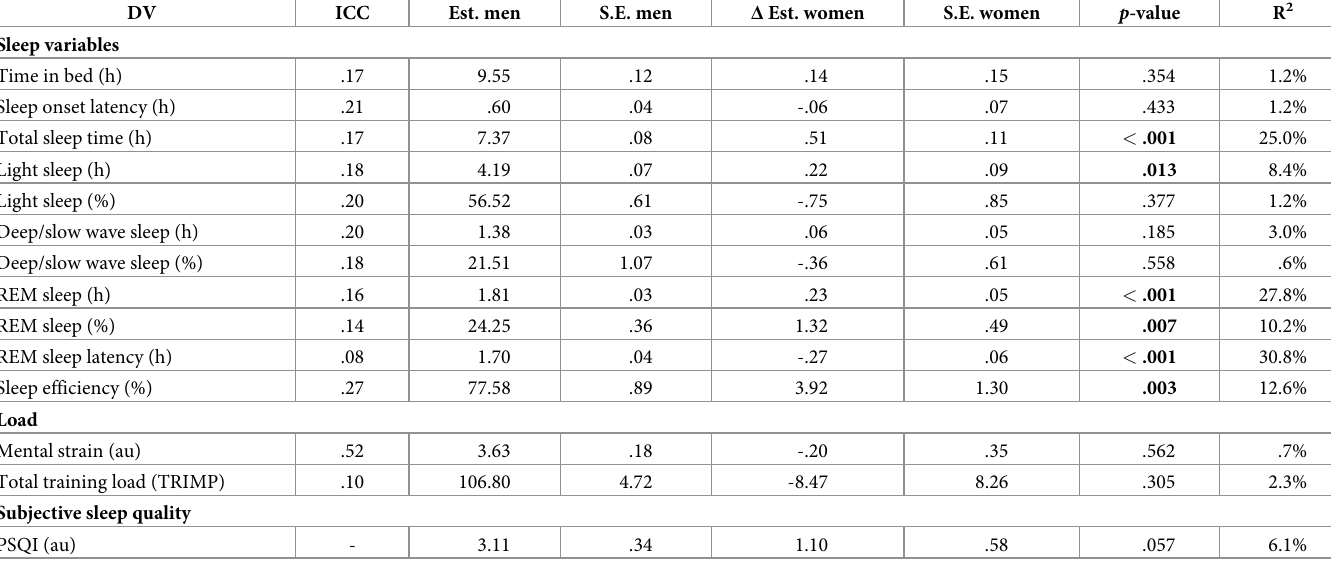
Table 2. Two-level random intercept regressions investigating sex differences (0 = men, 1 = women) in sleep and load variables, based on data from 37 male and 19 female endurance athletes. DV ICC Est. men